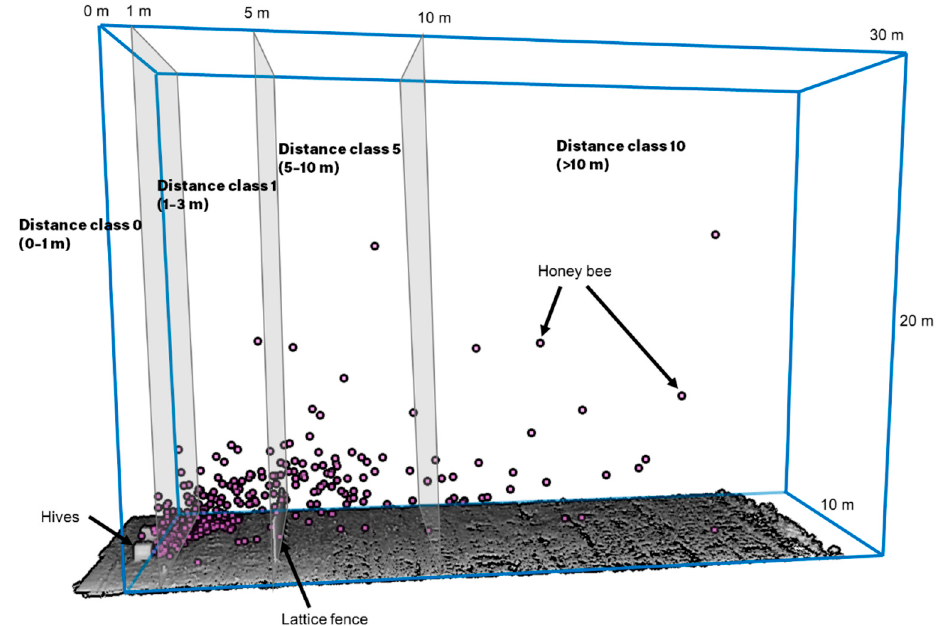
Figure 2. Layout of the experimental apiary. The lattice fence was placed 1 m or 5 m from the hive, and the 3D laser scanner was placed directly next to the lattice fence.